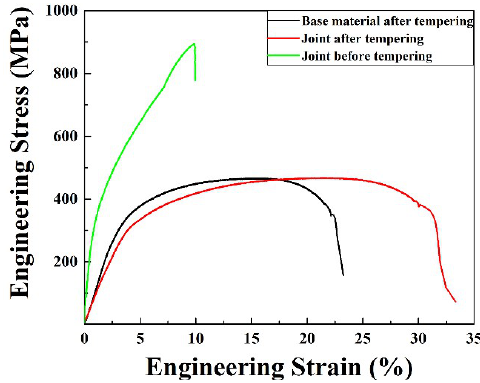
Figure 10. Tensile stress–strain curve of the base material after tempering and the joint before and after tempering.